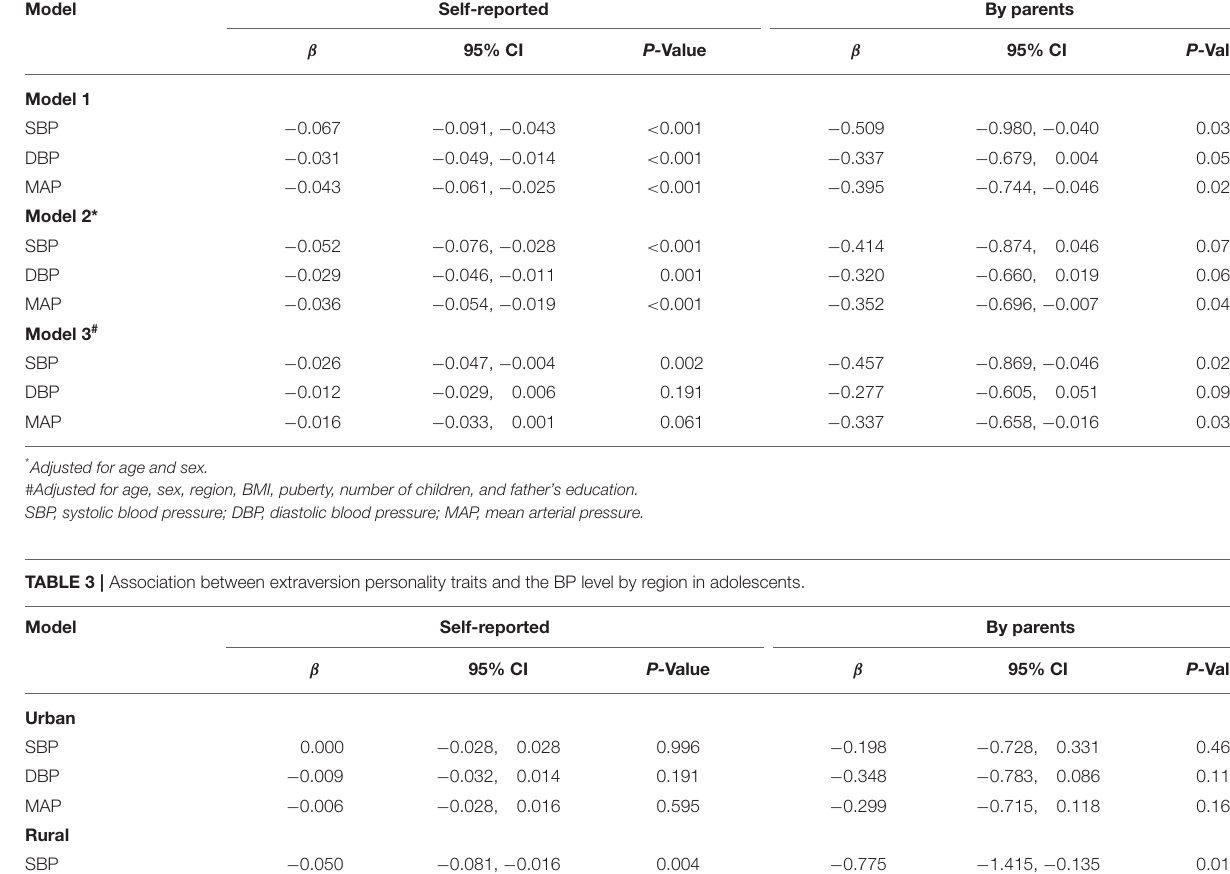
TABLE 2 | Association between extraversion personality and the blood pressure (BP) level in adolescents. Model Self-reported By parents